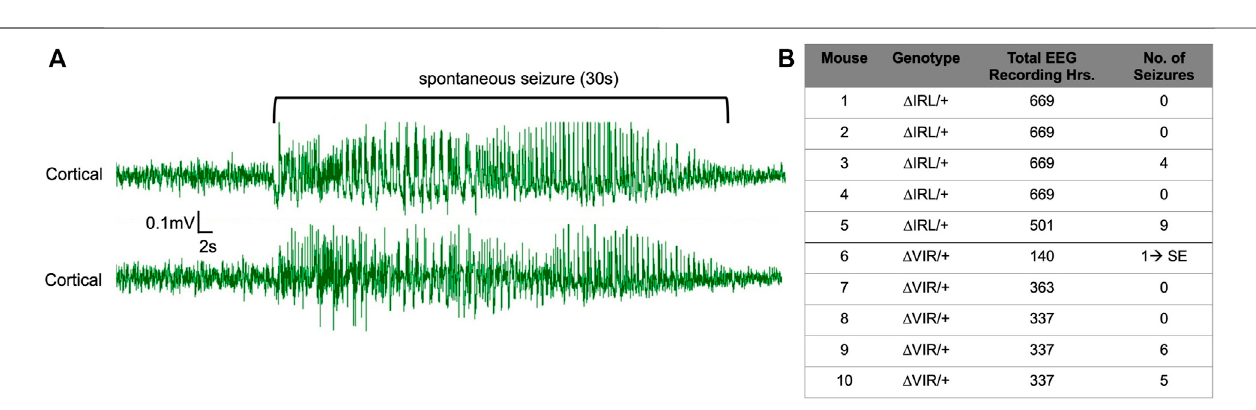
Frontiers in Pharmacology |